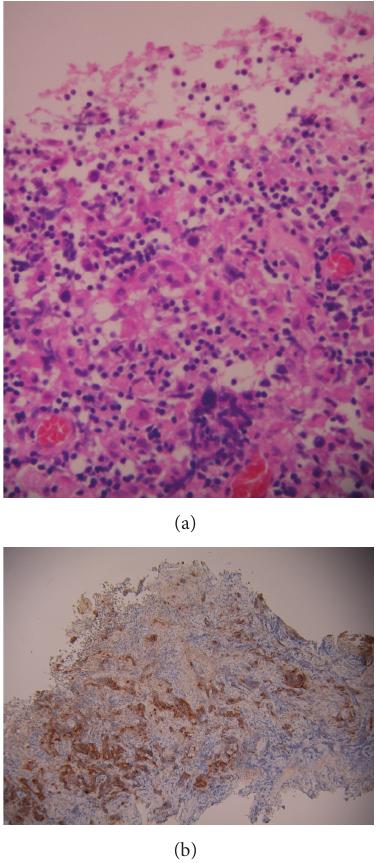
Figure 1: (a) Rather crushed biopsy of the pineal lesion showing lymphocytes surrounding occasional large epithelioid cells. (b) Pla- cental alkaline phosphatase (PLAP) immunohistochemical staining of the pineal lesion showing strong positivity within the crushed epithelioid cells in keeping with a germinoma.